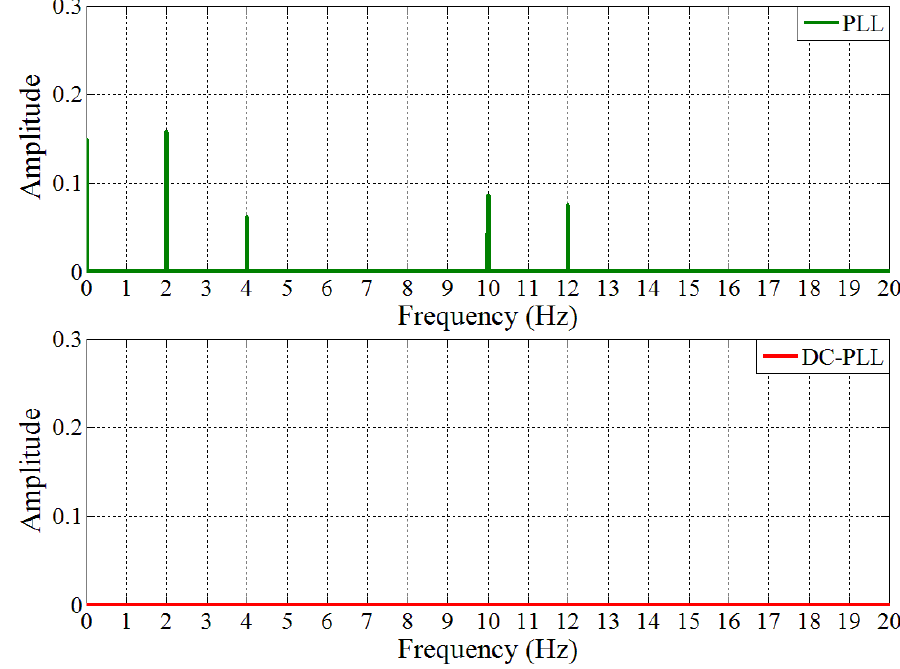
Figure 6. Phase detector error at fixed speed.